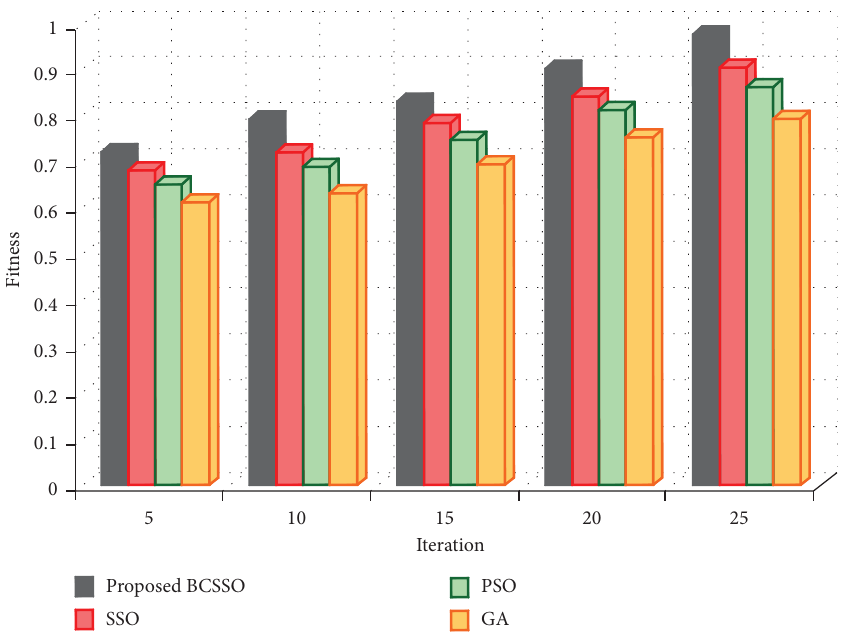
Figure 11: Graphical plot for ftness vs. iteration